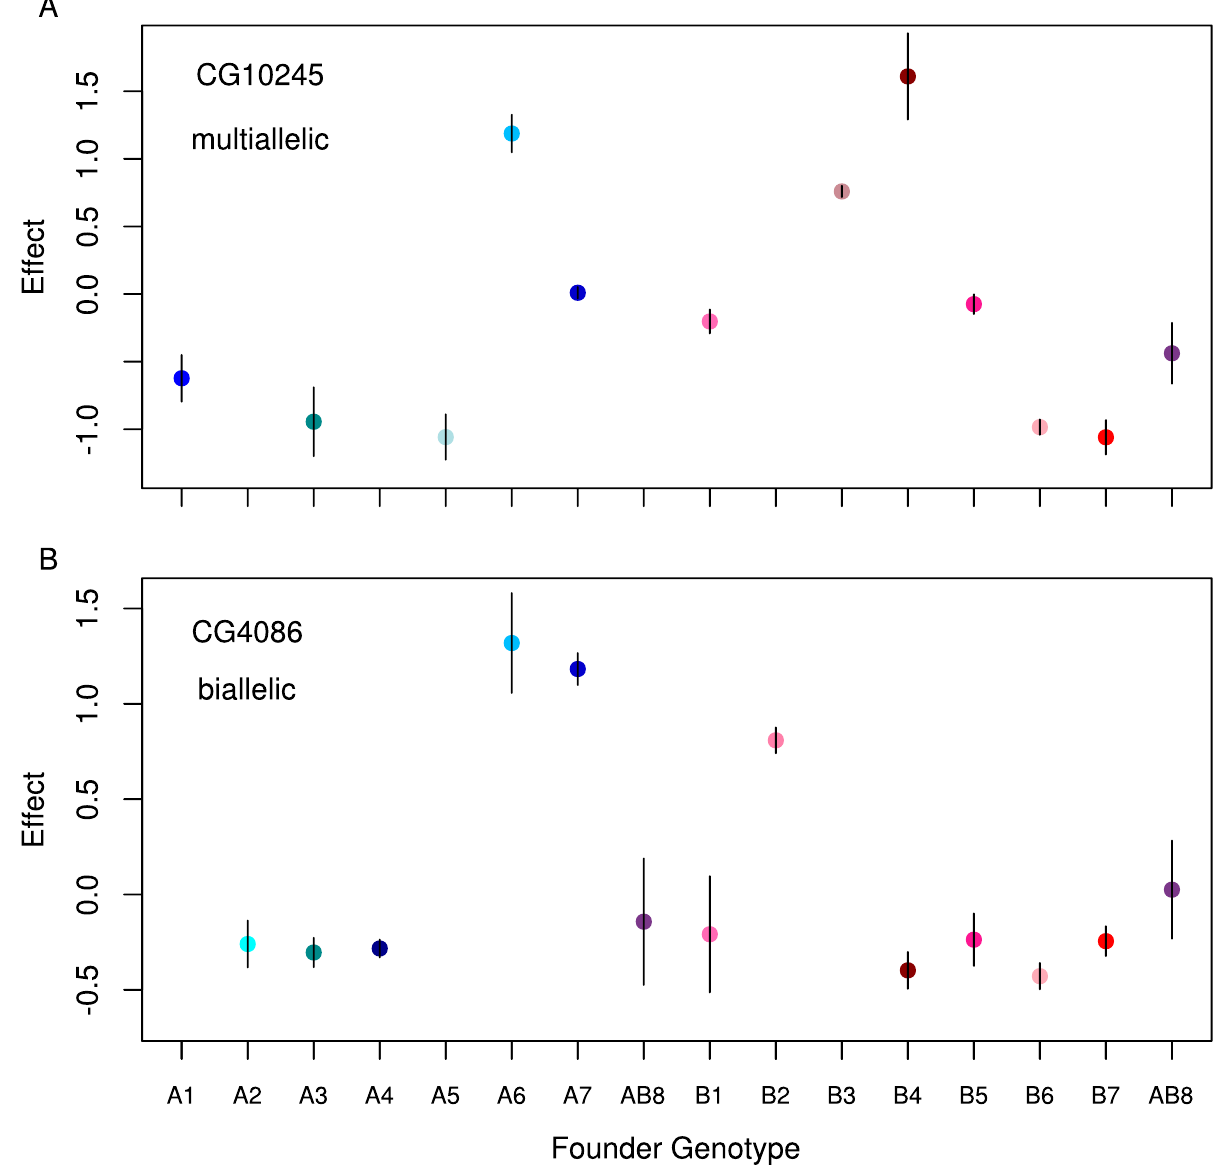
Figure 5. Standardized estimated means for each founder genotype for single observed cis -eQTL where A) the full model is the best model, and B) a two allele model is the best model. The gene name for each is displayed in the upper left